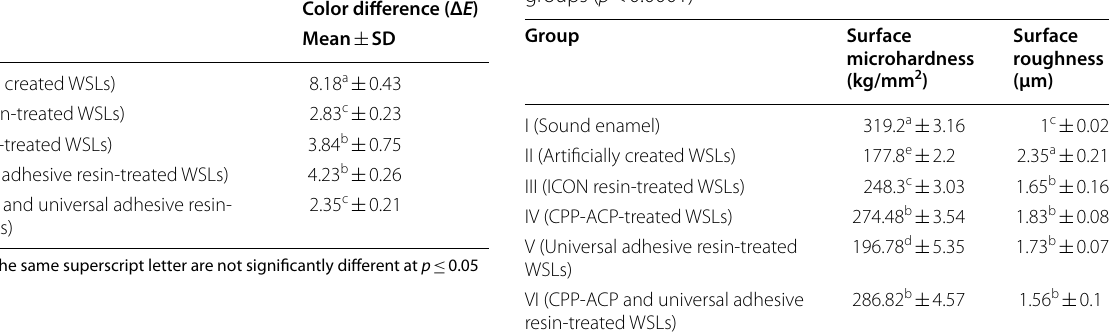
Table 2 Means, standard deviations, and Tukey’s analysis of the surface microhardness and surface roughness of the studied groups ( p < 0.0001)